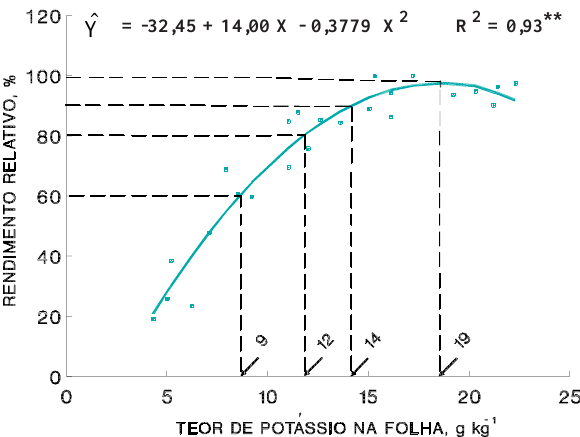
Figura 3. Rendimento relativo de soja em função do teor de potássio no tecido foliar. Resultado de quatro safras. Média de três